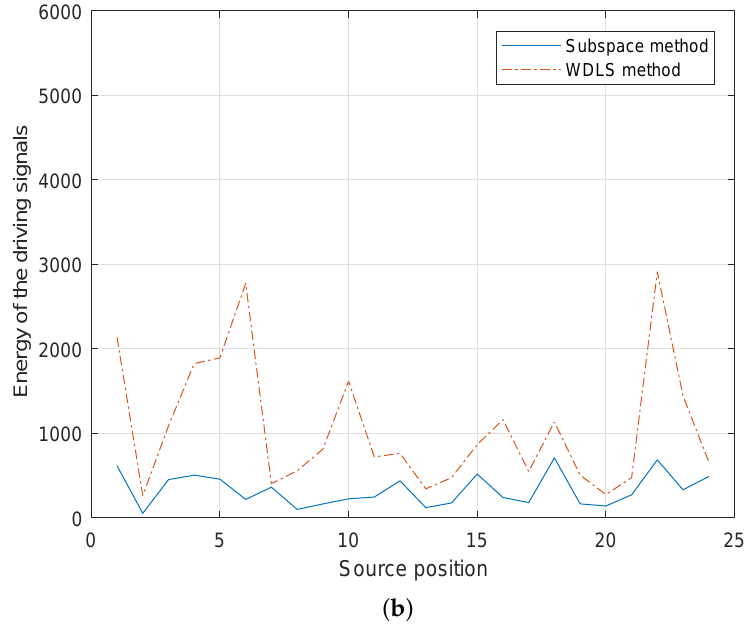
Figure 7. Energy of the driving signals in case 3, when the noise field is generated by one primary source moving around the sphere using different methods: ( a ) with SNR = 60 dB white noise on the microphone recordings; ( b ) with SNR = 30 dB white noise on the microphone